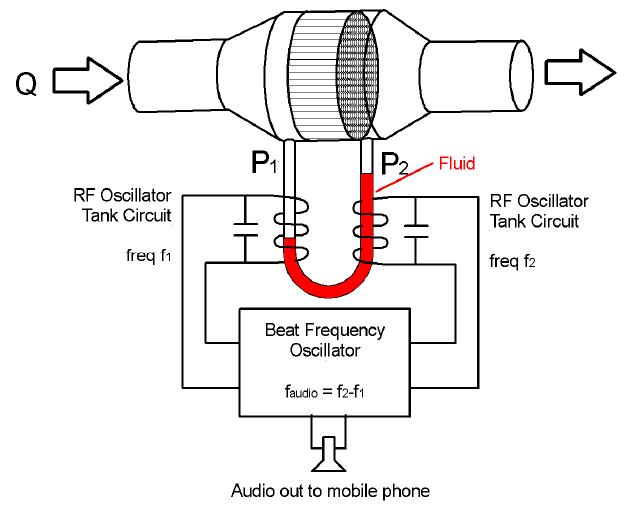
Figure 6. Conceptual diagram of a beat frequency oscillator based audio generator.